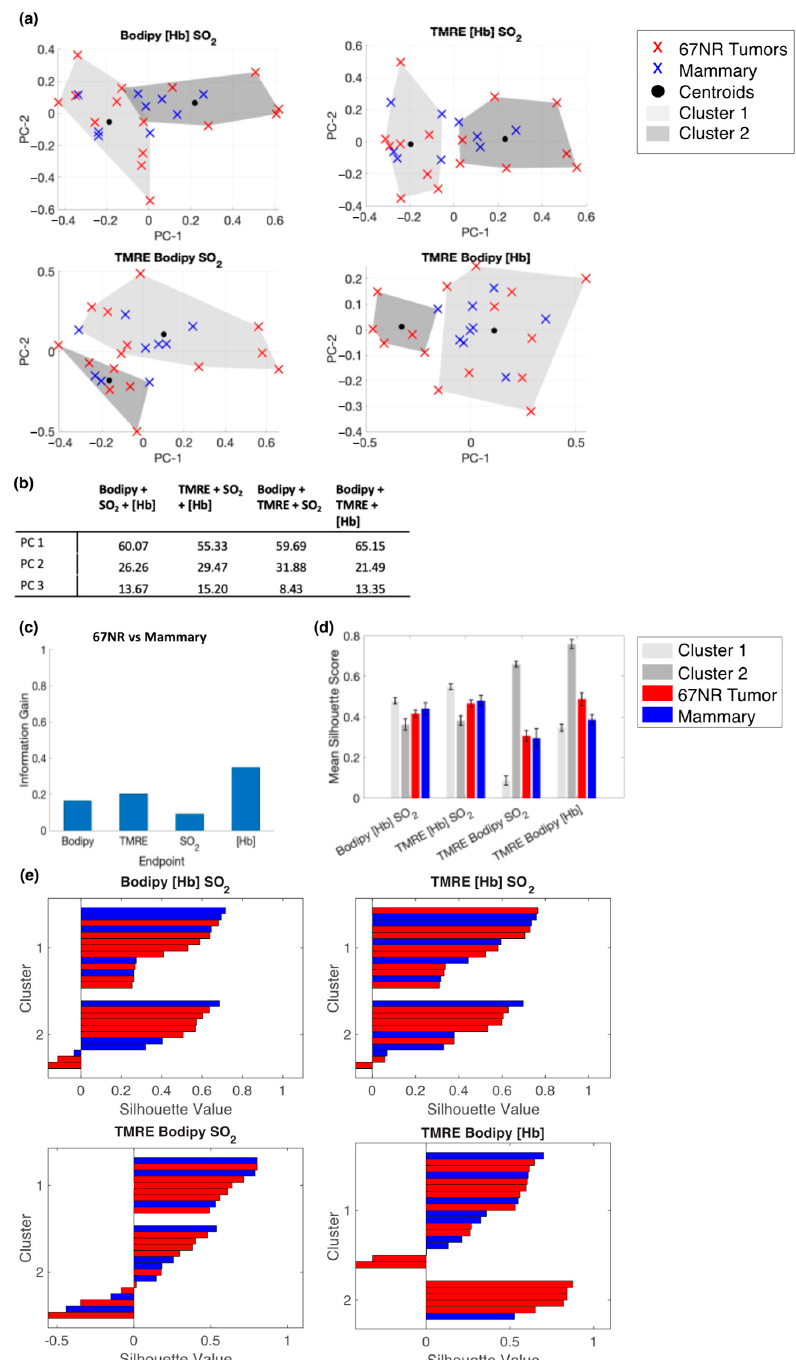
Figure 8. Bodipy FL C16 and TMRE fluorescence measurements combined with extracted vascular parameters do not separate clusters of normal and 67NR tumor tissue. ( a ) Projections of the first two PCs show spectral clustering results for four different combinations of the following endpoints: Bodipy FL C16 fluorescence intensity, TMRE fluorescence intensity, total hemoglobin concentration ([Hb]), and total oxygen saturation (SO 2 ). Fluorescence intensity is reported as the average intensity within 2.5 nm of the emission peak. ( b ) Table containing the variance described by each PC, by endpoint combination. ( c ) The calculated information gained from each variable. ( d ) The mean silhouette scores for cluster 1, cluster 2, data points with a true label of 67NR tumors, and data points with a true label of healthy mammary tissue. Error bars are SE. ( e ) Silhouette plots for each endpoint